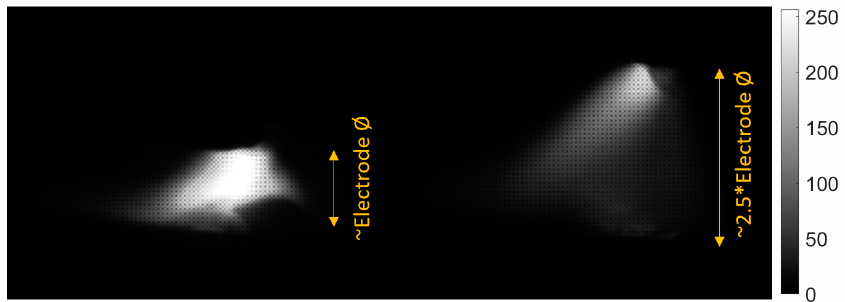
Figure 20. Arc length luminance and geometry variation, DC(+), 150A, at the begin of the arc glowing (left) and before arc extinction (right).